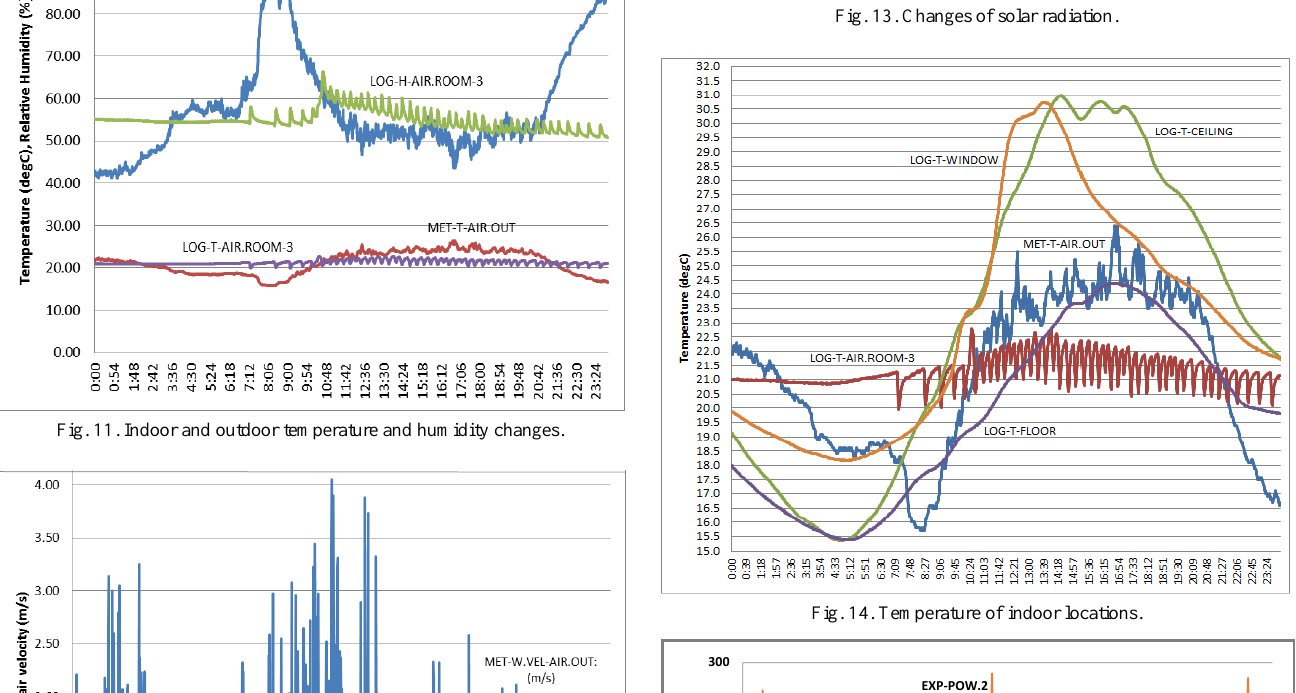
EXP-POW.1EXP-POW.2